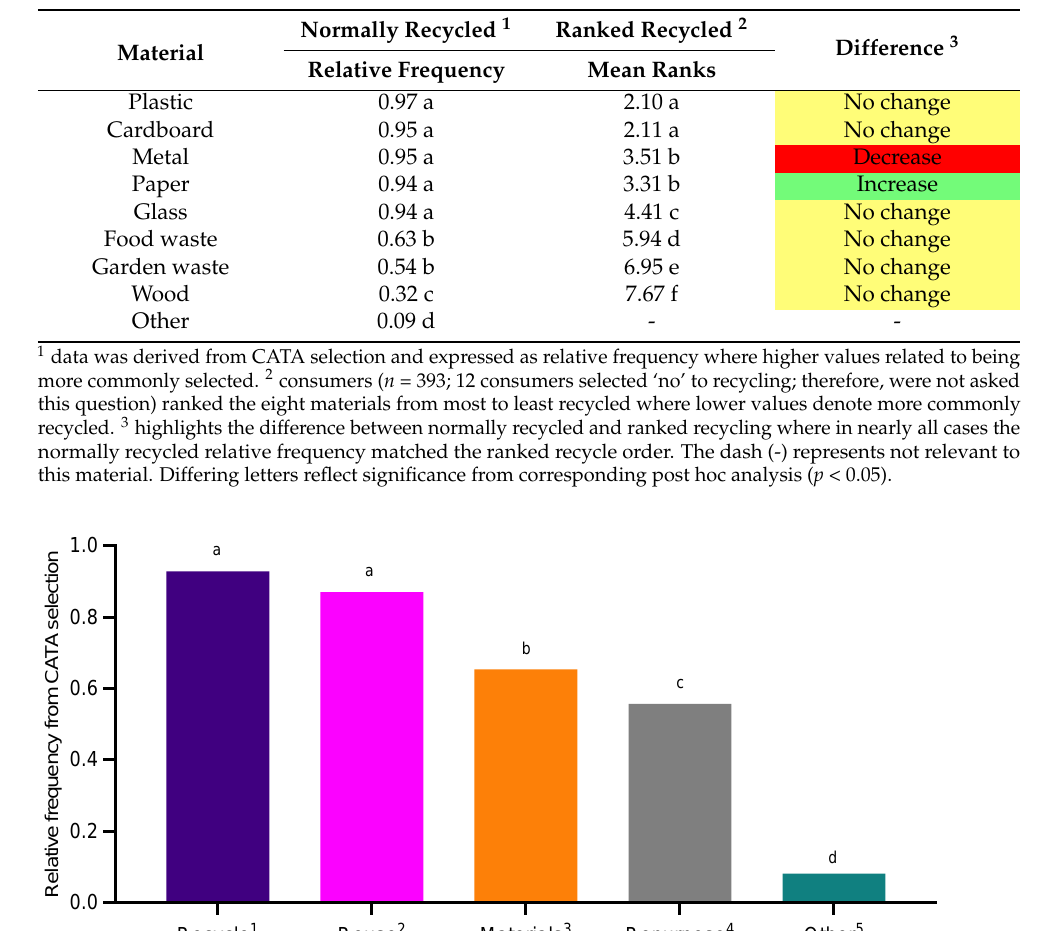
Table 3. Consumers ( n = 405) normally recycled materials and ranked order.